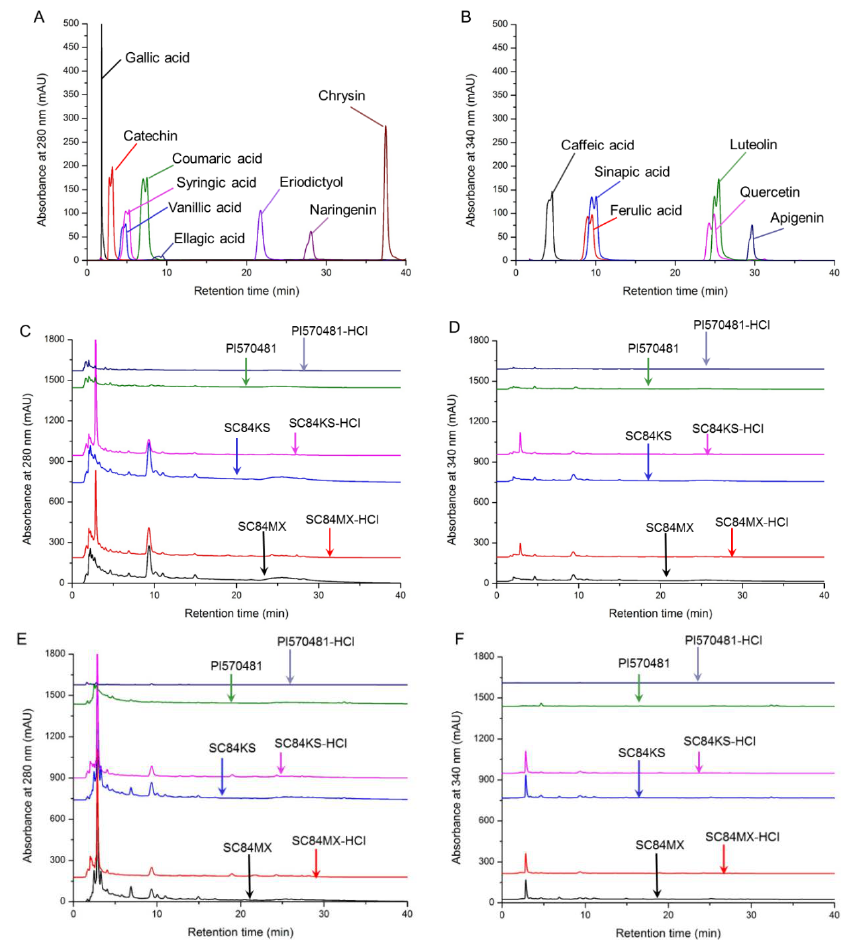
Figure 1. HPLC analysis of phenolic compounds in sorghum extracts. HPLC chromatograms of different phenolic standards detected at 280 nm ( A ) and 340 nm ( B ); HPLC chromatograms of sorghum water extracts detected at 280 nm ( C ) and 340 nm ( D ); HPLC chromatograms of sorghum ethanol extracts detected at 280 nm ( E ) and 340 nm ( F ).